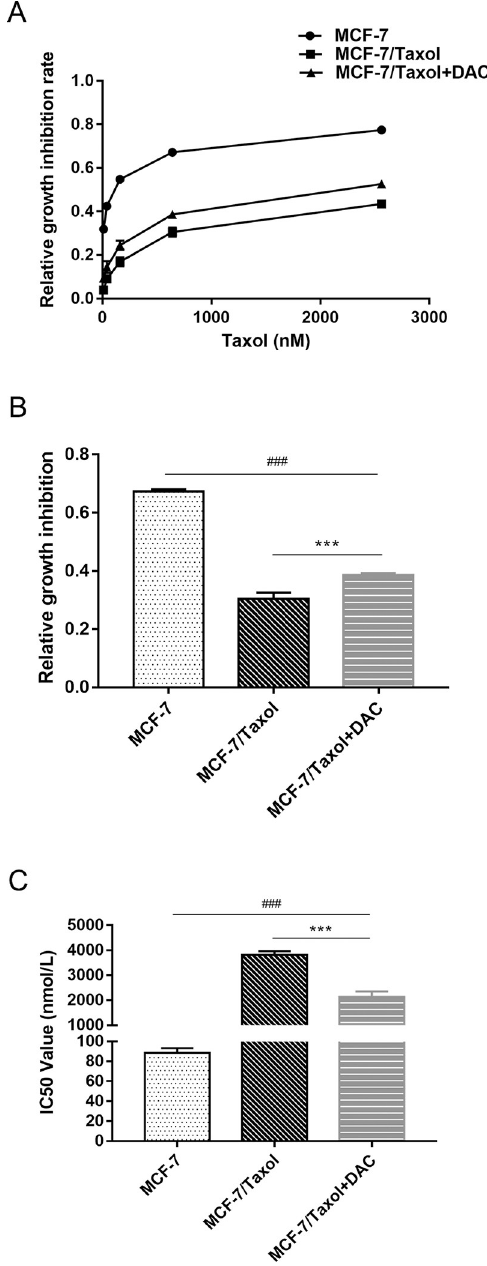
Fig 4. Combined decitabine and Taxol decreases MCF-7/Taxol cells proliferation and can improve their chemosensitivity. A. Cell growth inhibition rate of breast cancer cell lines was determined by CCK-8 assay after demethylation with 0.5uM decitabine and treatment with different concentrations of Taxol for 24h. B. Cell growth inhibition rate was showed by CCK-8 assay after demethylation with 0.5 uM decitabine and treatment with 640 nM Taxol. C. Cell proliferation was determined after treatment with different concentrations of Taxol for 72h. Data are expressed as the mean ± SD of three independent experiments. ��� P < 0.001 vs control group, ### P < 0.001 vs control